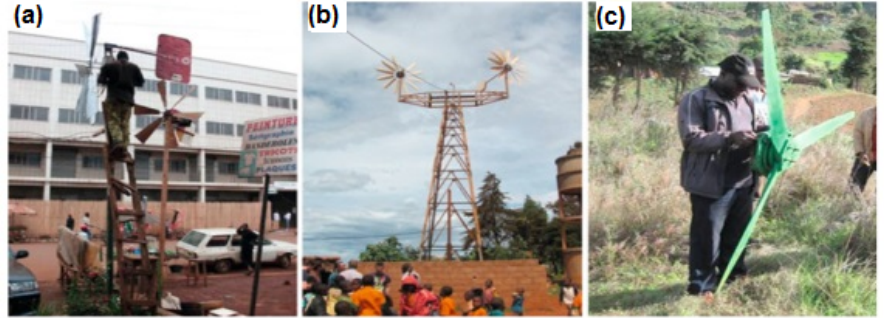
Figure 6. Wind turbines in some parts of Cameroon: ( a ) in Bafoussam; ( b ) in Bafou and ( c ) in M’muock